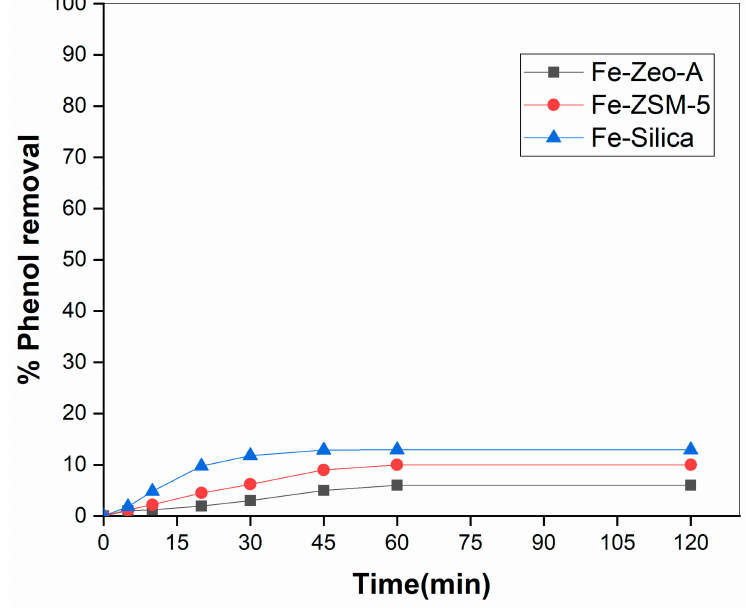
Figure 5. Heterogeneous photolytic degradation of